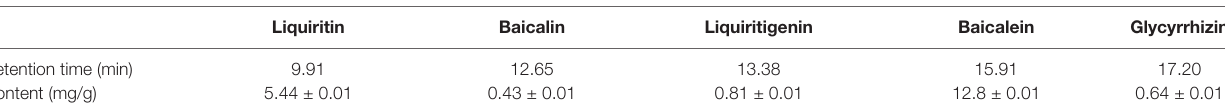
TABLE 4 | Compounds from